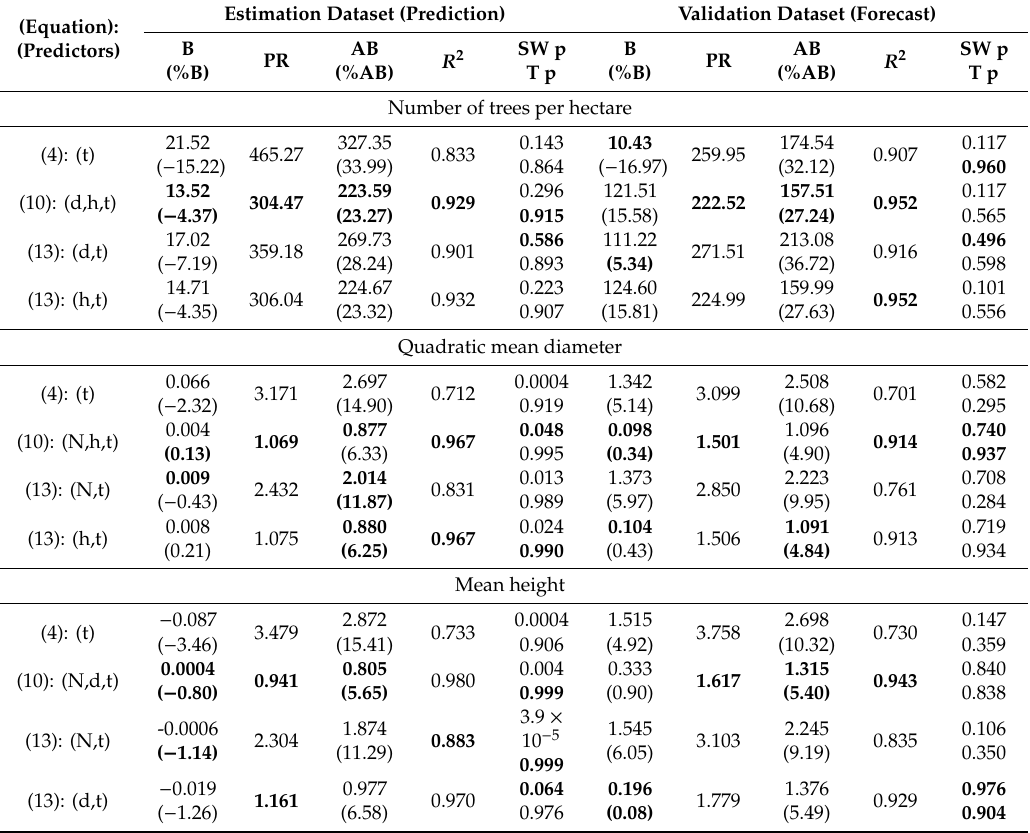
Table 3. Statistical indexes and p -values of the Shapiro-Wilk (SW p ) and Student (T p ) tests for the fixed e ff ect scenario models